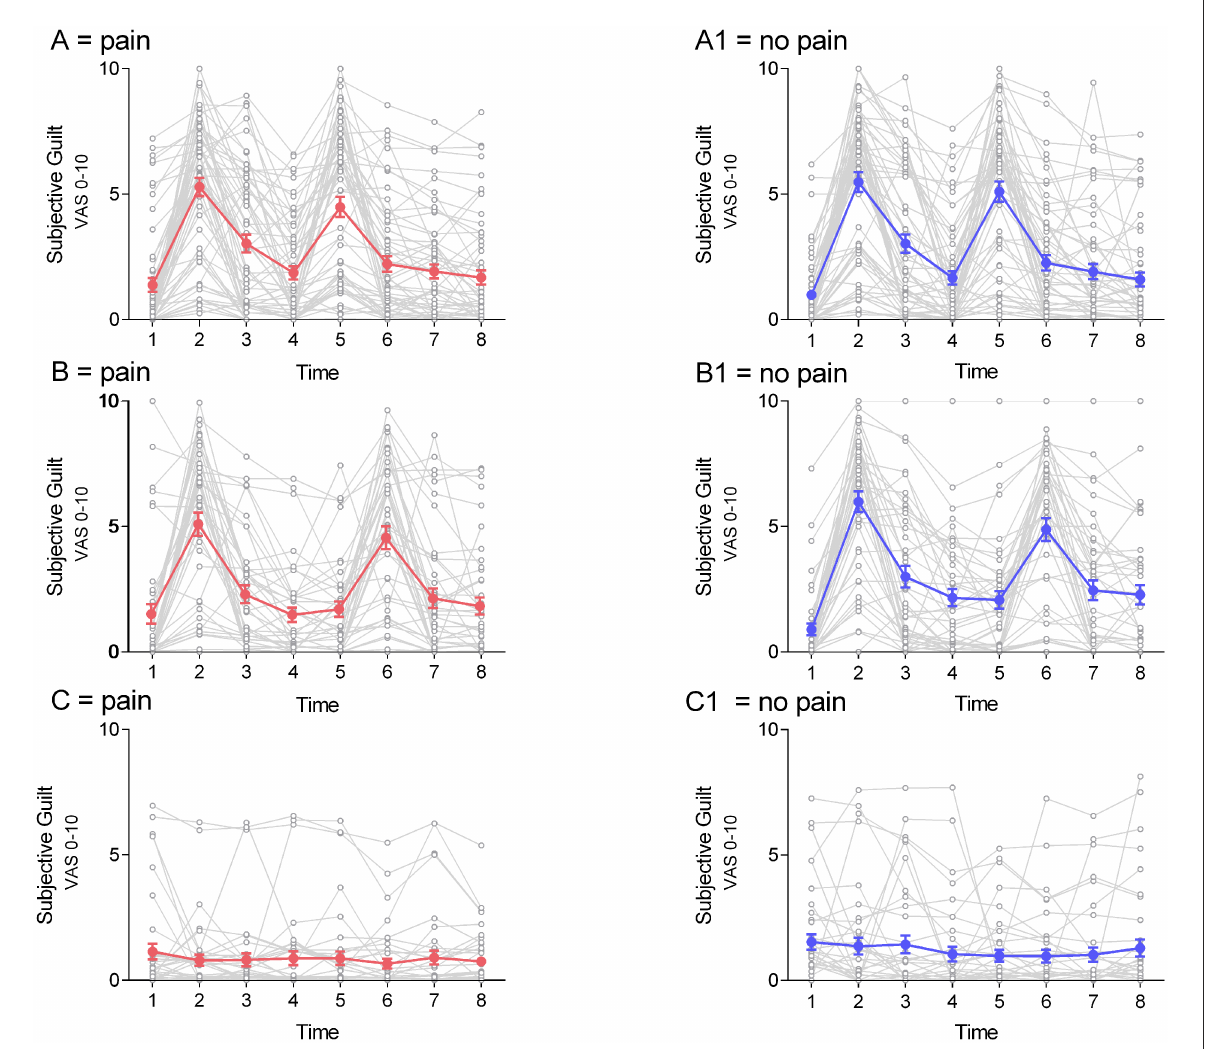
FIGURE3 Course of guilt on test-days. Data of individual guilt ratings (mean ± sem) are shown over time in all 3 groups (A) guilt-induction/heat-pain; (B) guilt-induction/cold-pressure-pain; (C) neutral emotion induction/heat-pain) for both test-days. Guilt in the supra-threshold pain-condition is shown in red (A–C) . The guilt line of the respective sham condition is shown in blue (A1–C1)